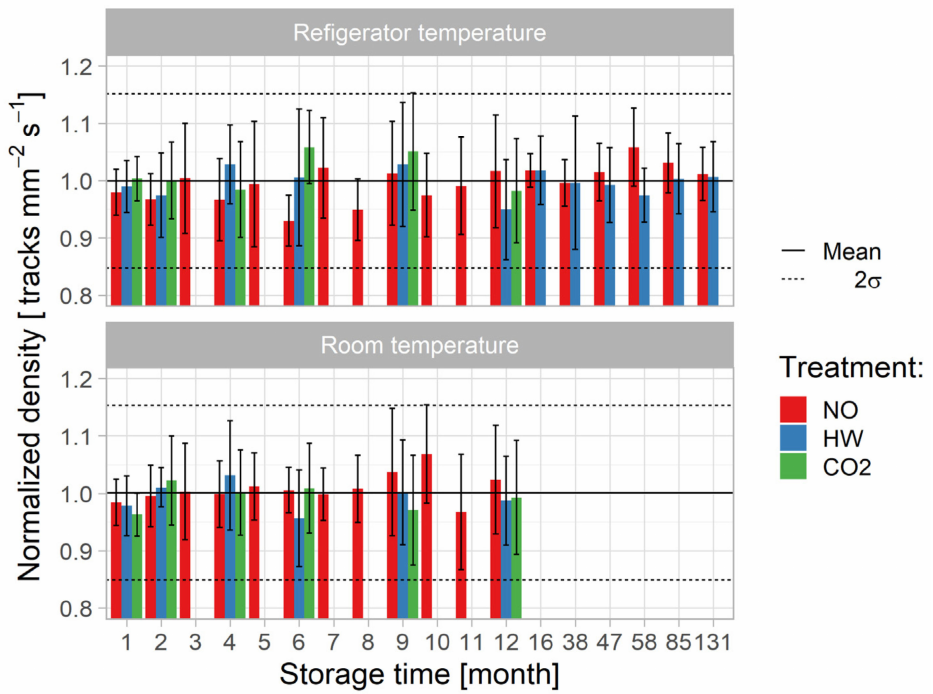
Figure 3. Track density versus storage time and temperature (the results were normalized by the irradiation time since different irradiation times were used, ranging from 180–190